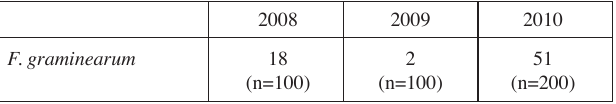
Fig. 3: Deoxynivalenol and nivalenol in naturally infected durum wheat